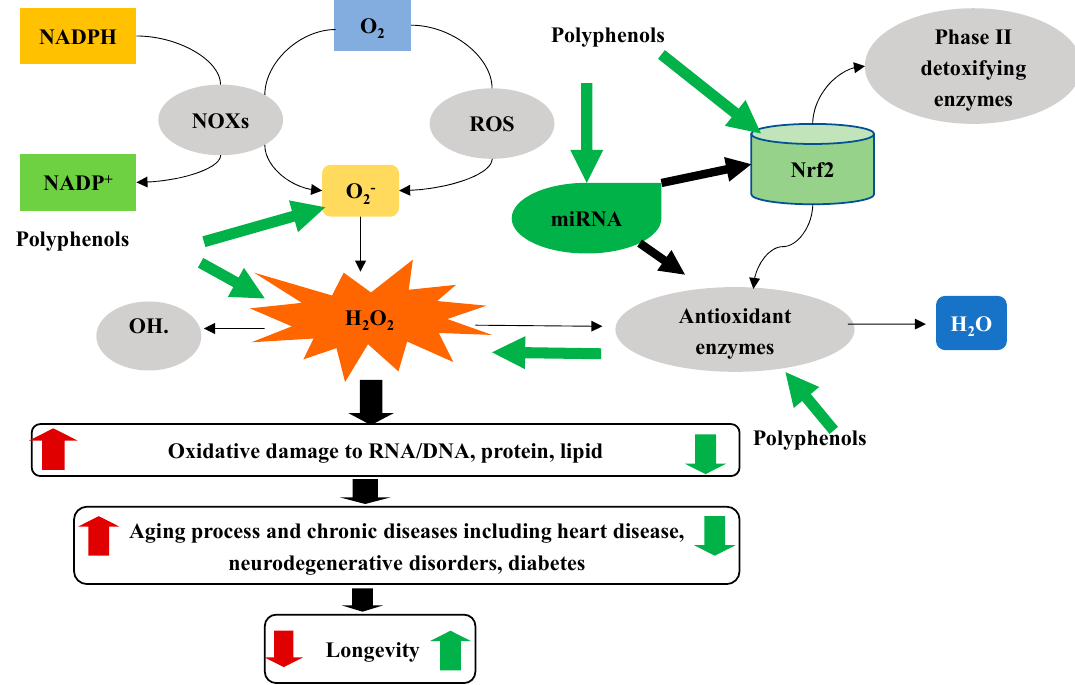
Figure 1. Schematic diagram of polyphenols antioxidant mechanisms. ROS, reactive oxygen species; Nrf2, nuclear factor erythroid 2-related factor 2.